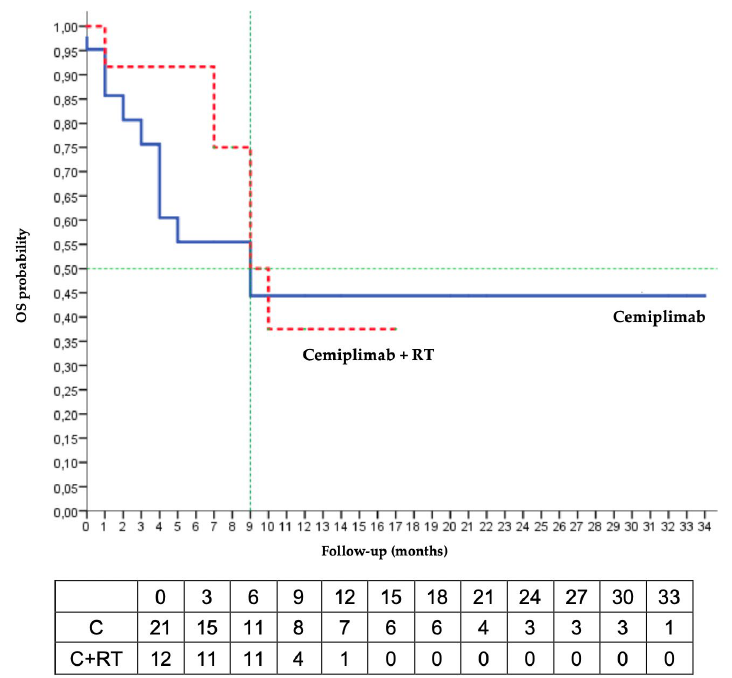
Figure 1. Kaplan–Meier analysis of overall survival (RT radiotherapy; OS: overall survival). Radiotherapy showed a positive clinical effect in 83.3% of the patients ( n = 10/12). A comparison test against the hypothesis of no effectiveness (50/50) found a therapeutic ef- fect of radiotherapy ( p = 0.037). Median OS was not reached when radiotherapy was used with curative intent, versus 7 months when the intent was palliative (Figure 2).